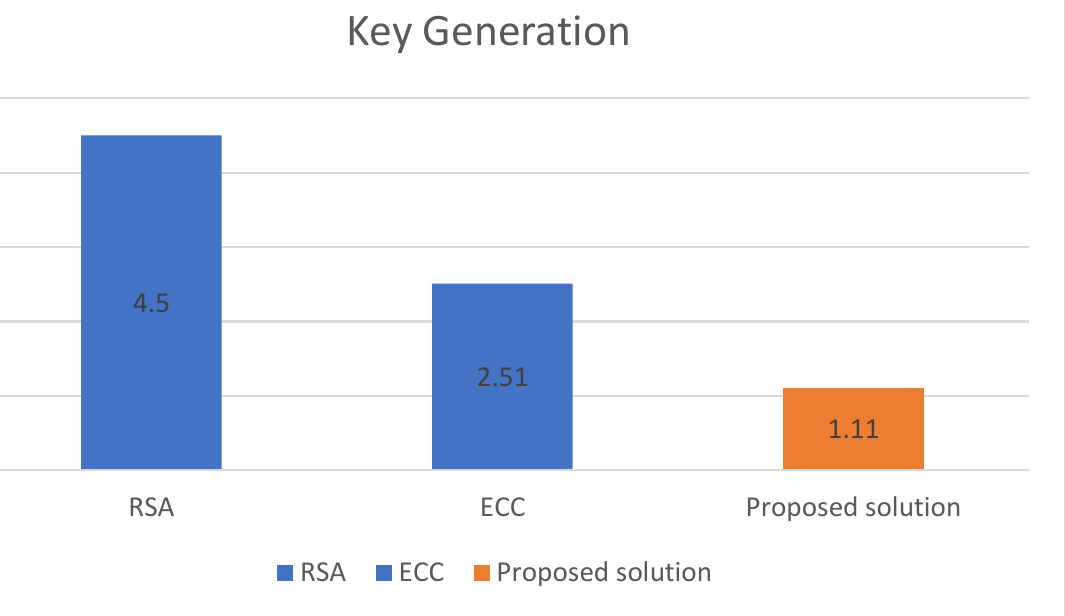
Figure 9. Key generation time.